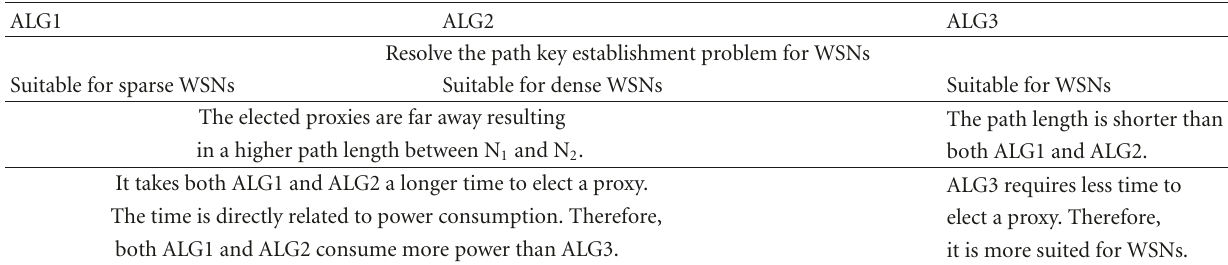
Table 1: Comparison of ALG1, ALG2, and